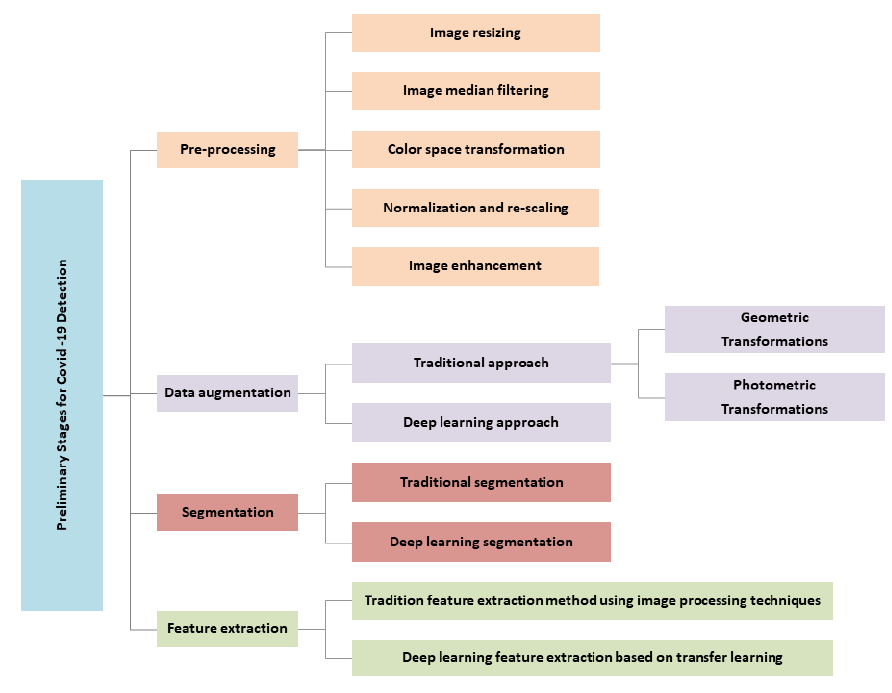
Figure 1. Proposed taxonomy of the preliminary stages of COVID-19